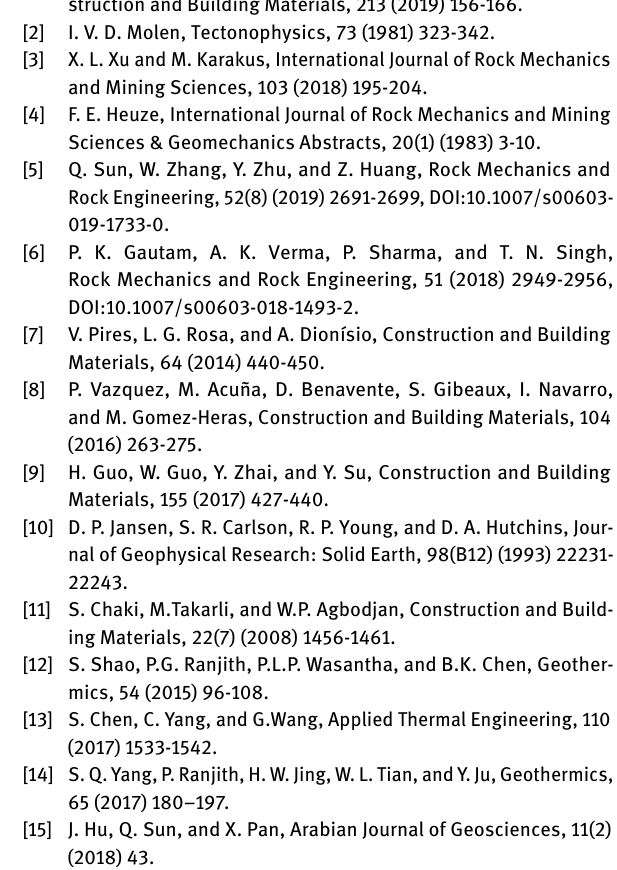
process of the dD σcT . More microcracks are produced